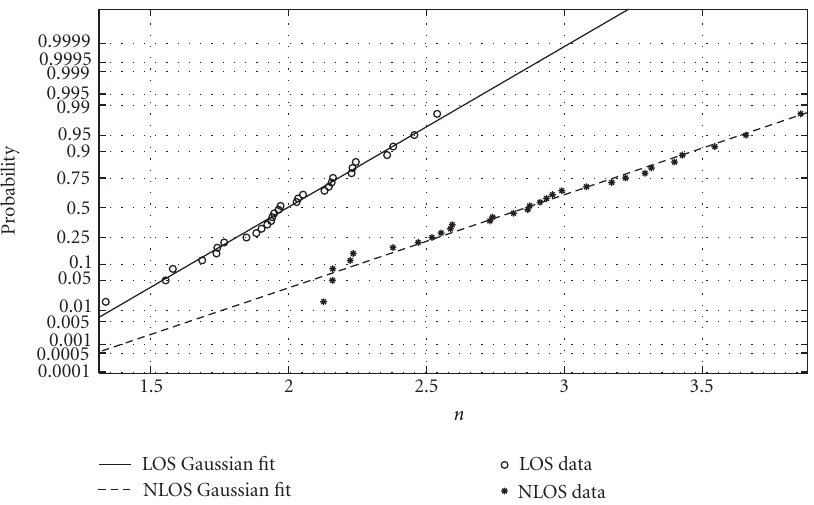
Figure 5: CDF of the deviation of path-loss exponent n in all measurement o ffi ce rooms at 5.8 GHz.